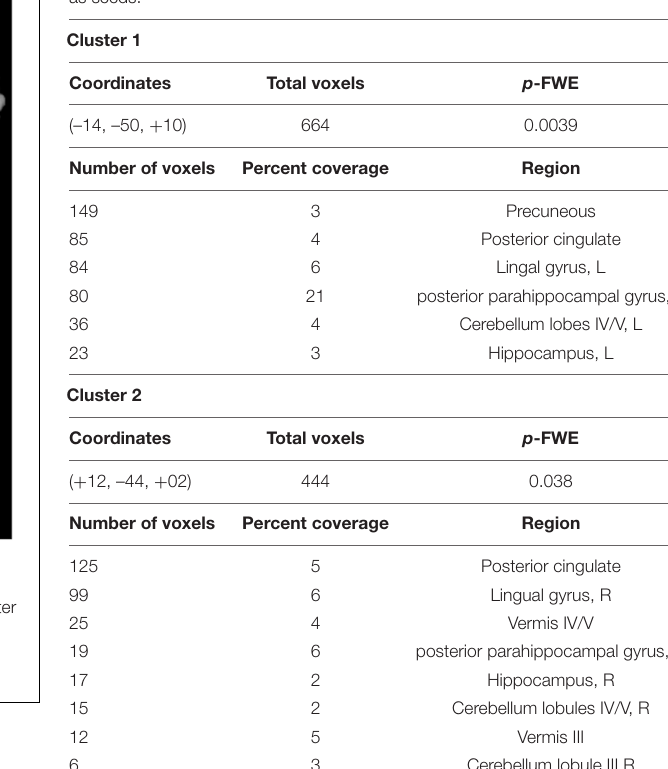
TABLE 4 | Composition of significant clusters in a seed-to-voxel analysis comparing aged users vs. aged non-users, using bilateral cerebellar lobules IV/V as